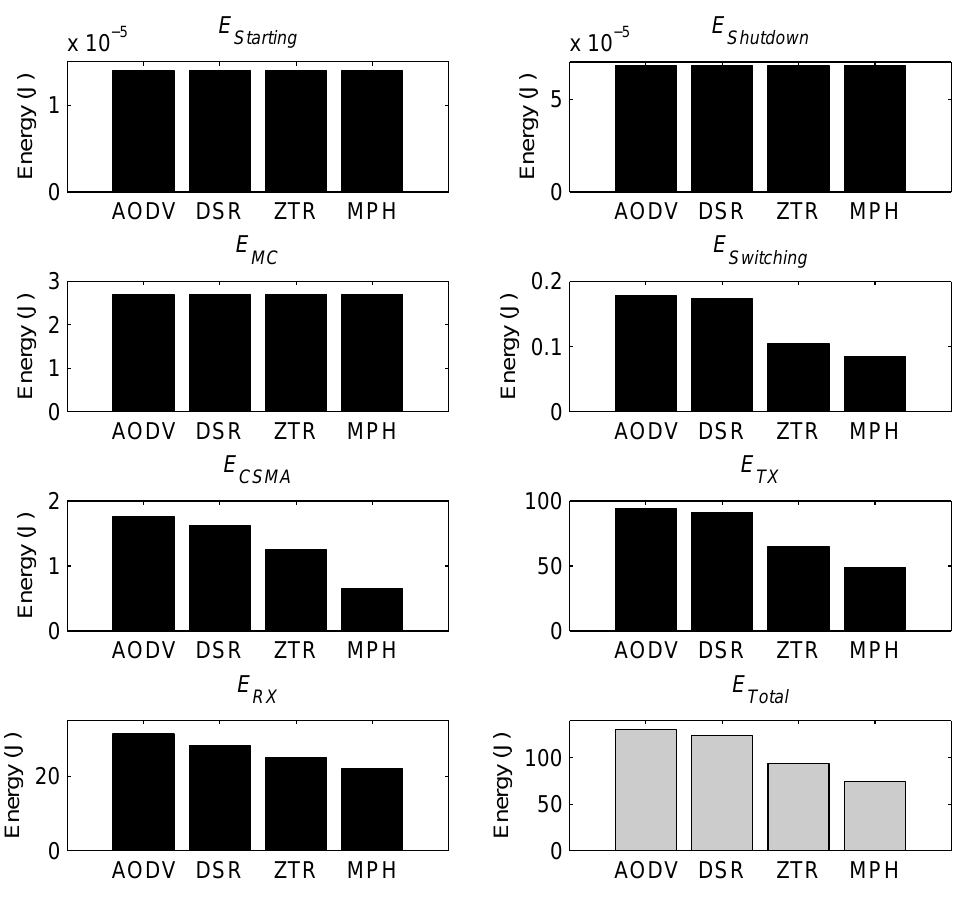
Figure 19. Consumed energies for AODV, DSR, ZTRand